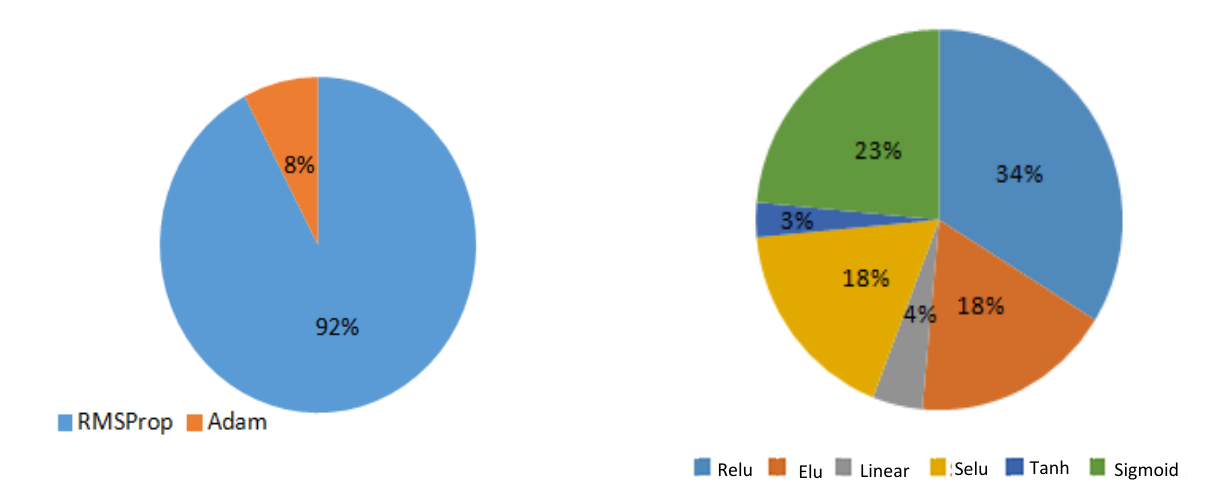
Figure 6. Statistics of the parameters of the best results.